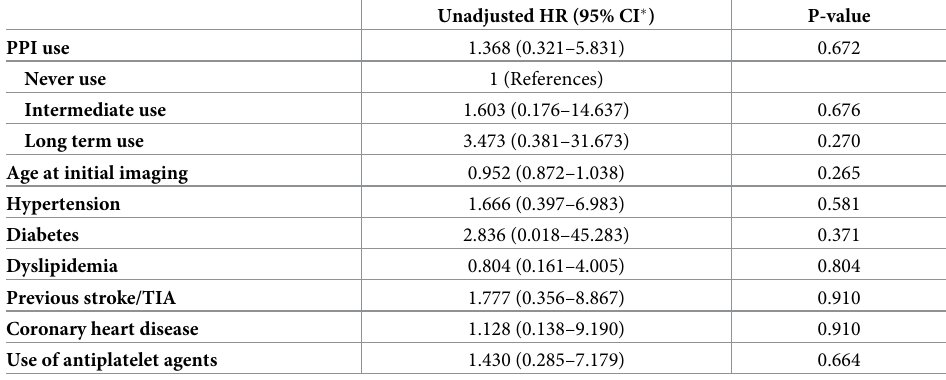
Table 3. Factors associated with the progression of